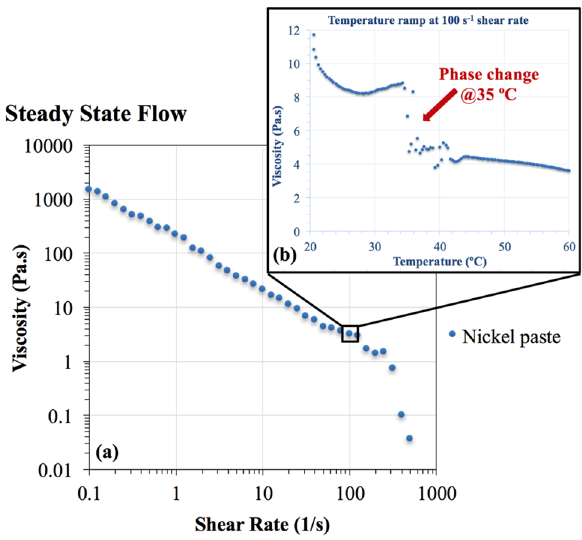
Figure 2. Ni ink flow curves: ( a ) viscosity dependence on the shear rate, ( b ) viscosity dependence on temperature measured with a constant 100 s -1 shear rate.